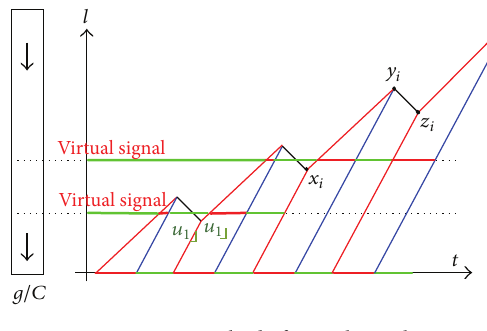
Figure 10: Method of virtual signal.